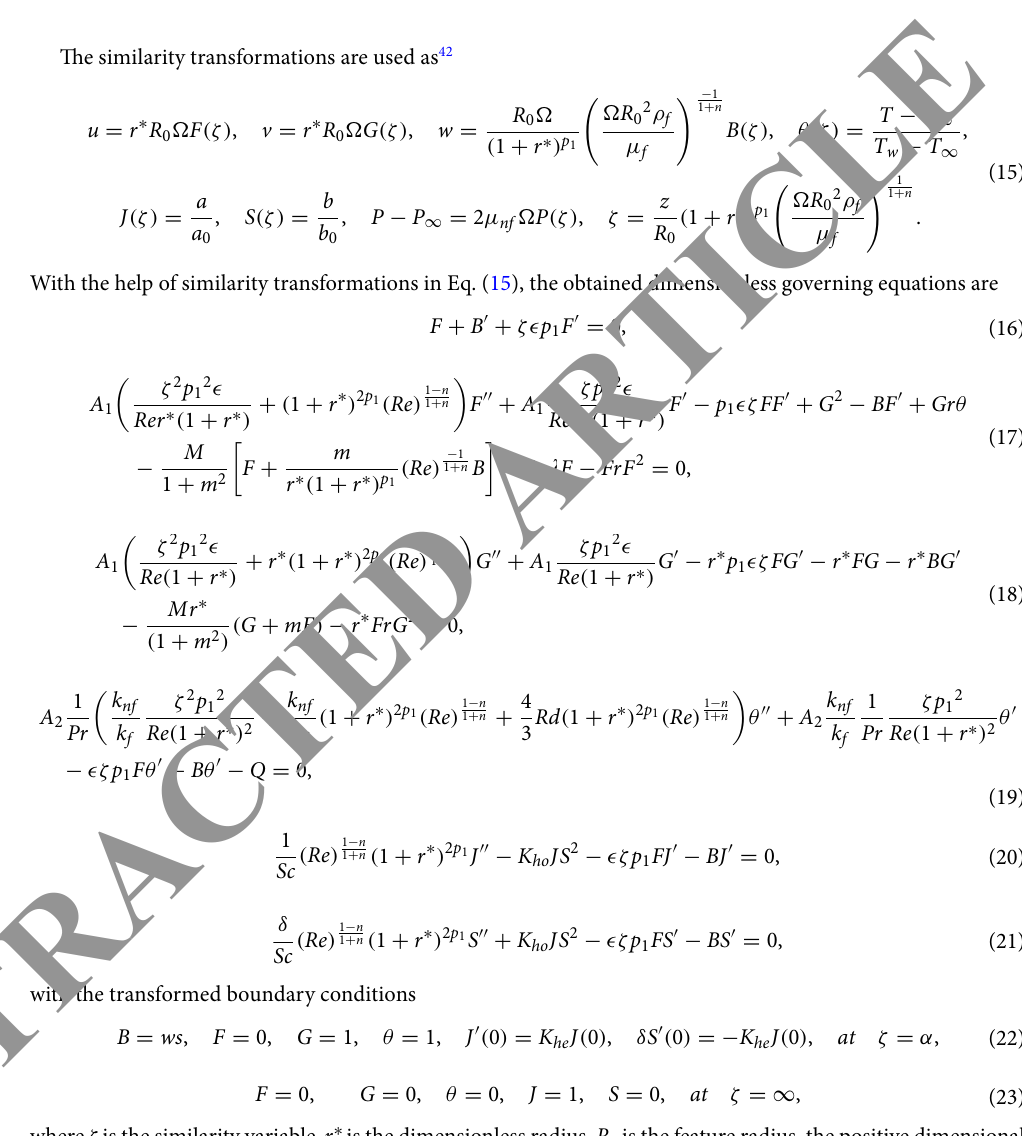
with the transformed boundary conditions